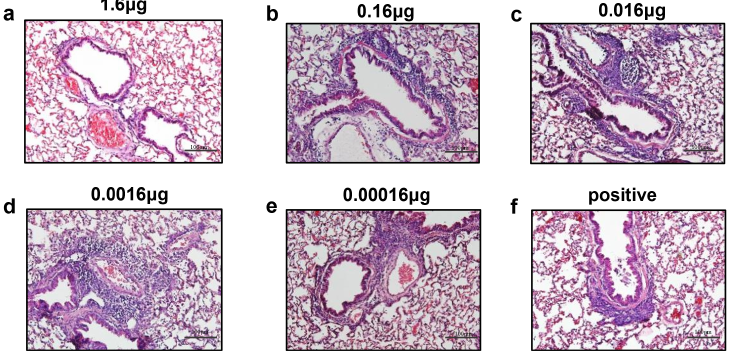
Figure 6. Representative haematoxylin and eosin stains for Alhydrogel-adjuvanted opti-FI-RSV at various doses are shown. ( a ) 1.6 µ g, ( b ) 0.16 µ g, ( c ) 0.016 µ g, ( d ) 0.0016 µ g, ( e ) 0.00016 µ g, ( f )